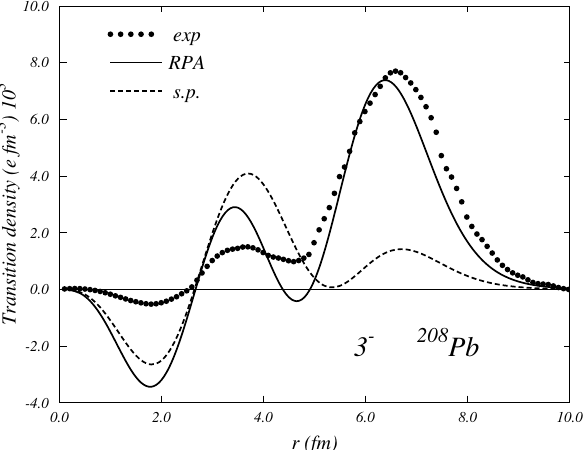
Figure 6. Electron scattering transition densities for the first 3 − excited state of 208 Pb. The empirical density, indicated by the dots, is extracted from the inelastic electron scattering data of Ref. [40]. The dashed line shows the transition density calculated in an IPM particle model where the state is described by the s.p. proton transition from the 1 s 1/2 hole state to the 2 f 7/2 particle state. The full line shows the RPA